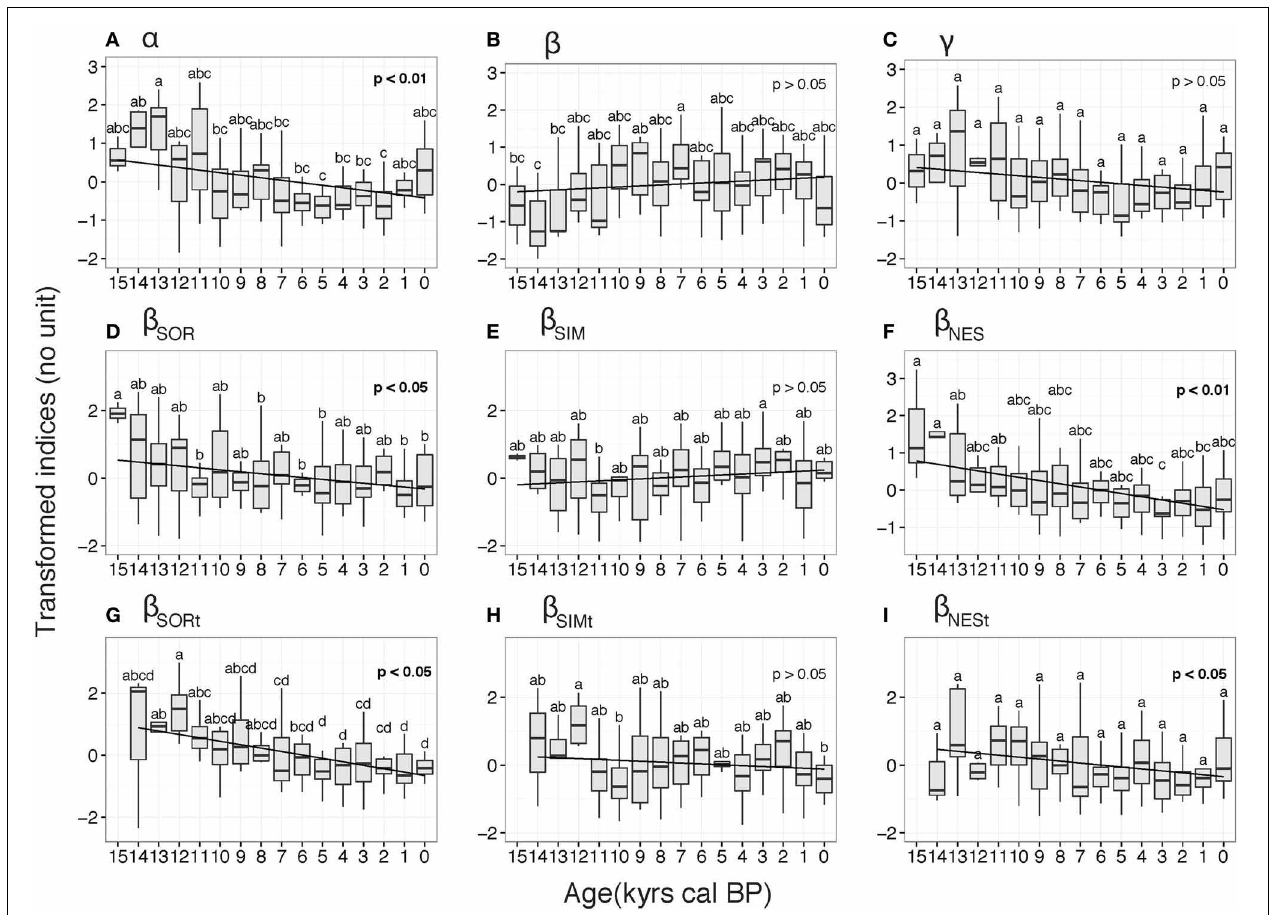
FIGURE 3 | Box plots of diversity indices for the North American boreal forest taiga biome derived from transformed indices. The indices are: (A) α diversity, (B) β diversity (C) γ diversity, (D) β SOR spatial diversity, (E) β SIM spatial turnover component, (F) β NES spatial nestedness component, (G) β SORt temporal diversity, (H) β SIMt temporal